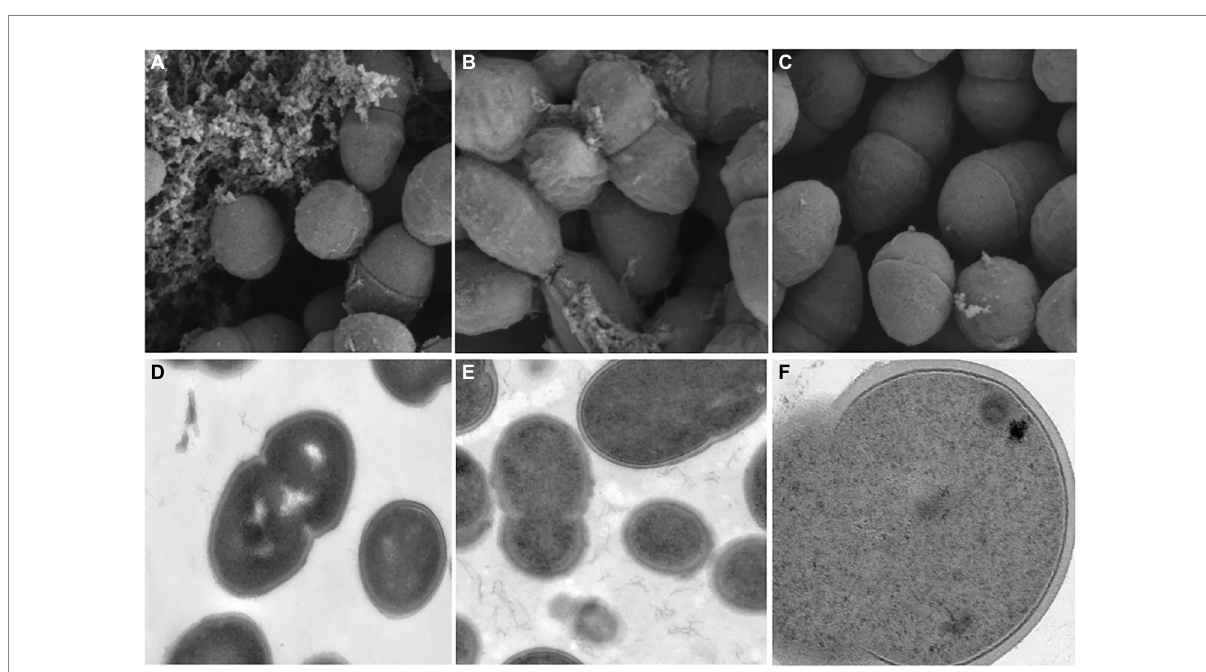
FIGURE 6 SEM images of E. faecium E3101 (A–C) , TEM images of E. faecium E3101 (D–F) . (A,D) represent untreated bacteria. (B,E) represent bacteria treated with ZJ-2 at 1/4 MIC. (C,F) represent bacteria treated with ZJ-2 at 1/2 MIC. SEM images’s view are 1.00 μ m, TEM images’s view are 5.00 μ m (D,E) , and TEM images’s view are 200 nm (F)